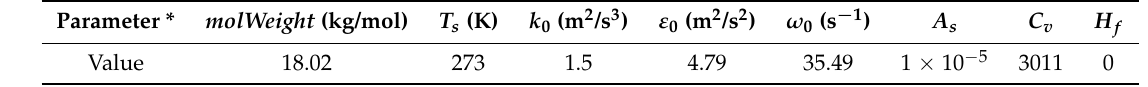
Table 2. The parameters for the PRT steam dumping